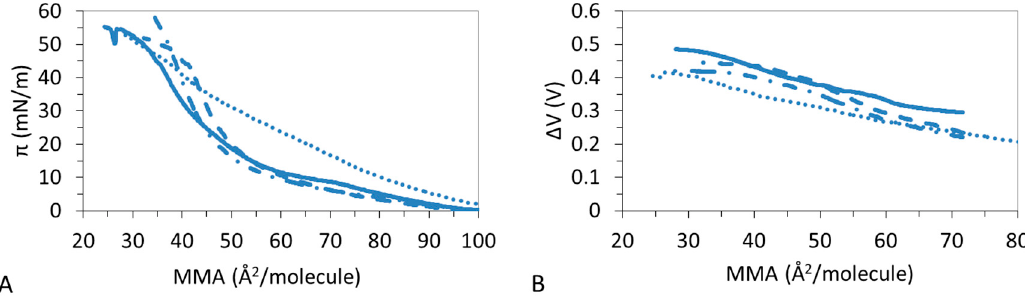
Figure 5. Effect of electrolyte on DPPC:DPPS 4:1 monolayers ( A ) π - A isotherms and ( B ) Δ V – A . 15 mM NaCl (straight line), 5 mM CaCl 2 (dashed line), 5 mM MgCl 2 (dash-dotted line), 2.5 mM LaCl 3 (dotted line). Curves replotted from Figure 1.